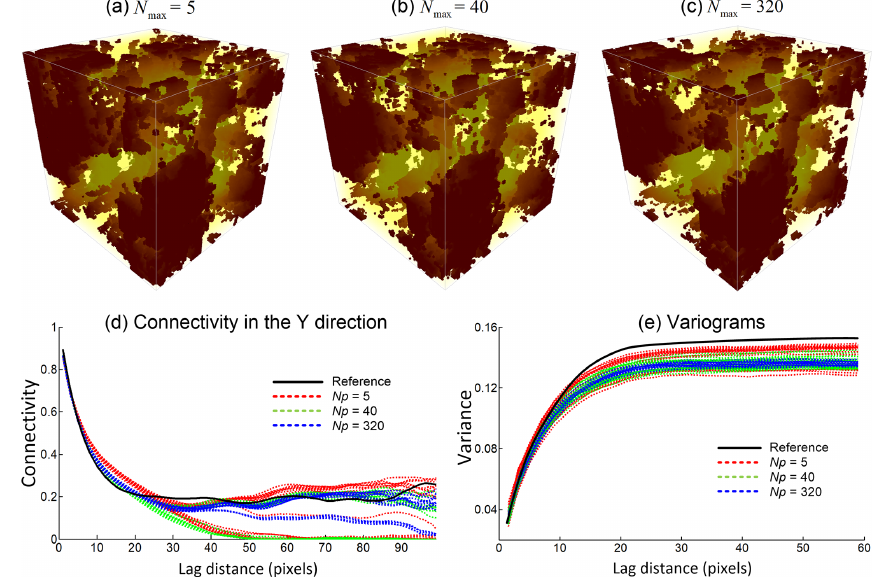
Figure 6. Reconstructions and their statistical properties with N max = 5, 40, 320 selected from Table 2.